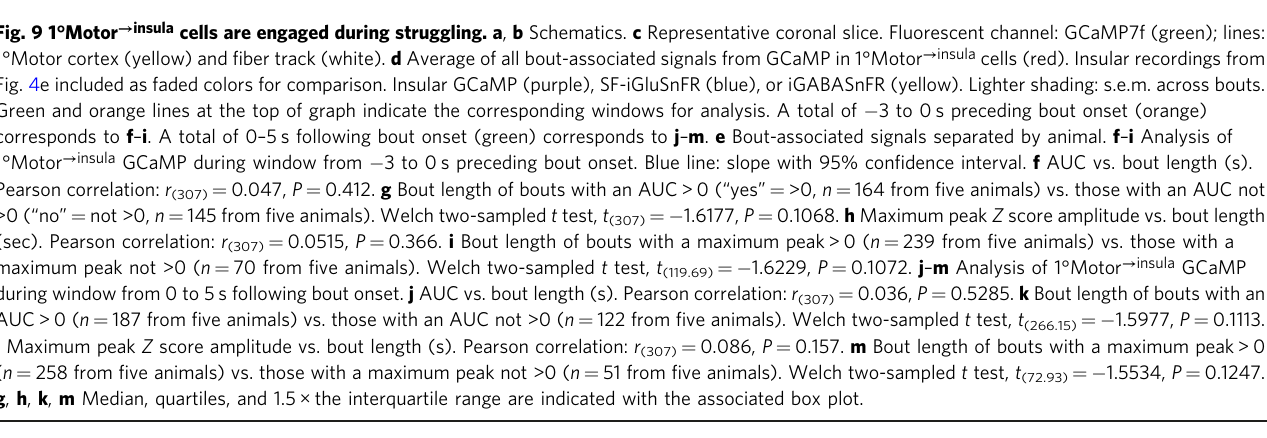
Fig. 9 1°Motor → insula cells are engaged during struggling. a , b Schematics. c Representative coronal slice. Fluorescent channel: GCaMP7f (green); lines: 1°Motor cortex (yellow) and fi ber track (white). d Average of all bout-associated signals from GCaMP in 1°Motor → insula cells (red). Insular recordings from Fig. 4e included as faded colors for comparison. Insular GCaMP (purple), SF-iGluSnFR (blue), or iGABASnFR (yellow). Lighter shading: s.e.m. across bouts. Green and orange lines at the top of graph indicate the corresponding windows for analysis. A total of − 3 to 0 s preceding bout onset (orange) corresponds to f – i . A total of 0 – 5 s following bout onset (green) corresponds to j – m . e Bout-associated signals separated by animal. f – i Analysis of 1°Motor → insula GCaMP during window from − 3 to 0 s preceding bout onset. Blue line: slope with 95% con fi dence interval. f AUC vs. bout length (s). Pearson correlation: r (307) = 0.047, P = 0.412. g Bout length of bouts with an AUC > 0 ( “ yes ” = >0, n = 164 from fi ve animals) vs. those with an AUC not >0 ( “ no ” = not >0, n = 145 from fi ve animals). Welch two-sampled t test, t (307) = − 1.6177, P = 0.1068. h Maximum peak Z score amplitude vs. bout length (sec). Pearson correlation: r (307) = 0.0515, P = 0.366. i Bout length of bouts with a maximum peak > 0 ( n = 239 from fi ve animals) vs. those with a maximum peak not >0 ( n = 70 from fi ve animals). Welch two-sampled t test, t (119.69) = − 1.6229, P = 0.1072. j – m Analysis of 1°Motor → insula GCaMP during window from 0 to 5 s following bout onset. j AUC vs. bout length (s). Pearson correlation: r (307) = 0.036, P = 0.5285. k Bout length of bouts with an AUC > 0 ( n = 187 from fi ve animals) vs. those with an AUC not >0 ( n = 122 from fi ve animals). Welch two-sampled t test, t (266.15) = − 1.5977, P = 0.1113. l Maximum peak Z score amplitude vs. bout length (s). Pearson correlation: r (307) = 0.086, P = 0.157. m Bout length of bouts with a maximum peak> 0 ( n = 258 from fi ve animals) vs. those with a maximum peak not >0 ( n = 51 from fi ve animals). Welch two-sampled t test, t (72.93) = − 1.5534, P = 0.1247. g , h , k , m Median, quartiles, and 1.5 × the interquartile range are indicated with the associated box